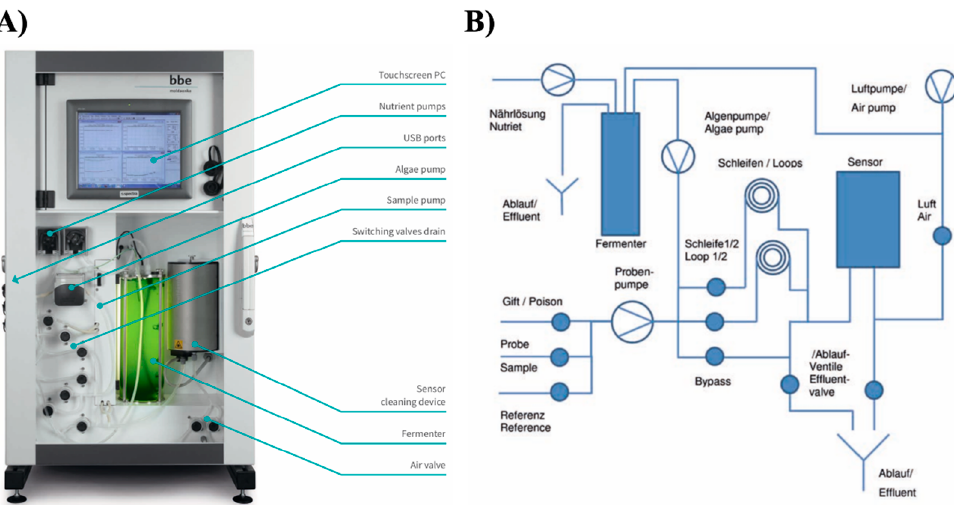
Figure 3. The Algae Toximeter II (bbe Moldaenke GmbH, Germany) is a commercial water biomon- itoring system utilising Chlorella vulgaris microalgae as a bioindicator organism. ( A ) Overview of the device, depicting major functional components. Note an automated on-board photobioreac- tor/fermenter that provides continuous culture of microalgae. Analysis of each water sample takes approximately 45 min and, thus, the Algae Toximeter II is an example of time-resolved but not real- time water sensing technology; ( B ) Technical diagram of the system with its main functional com- ponents. Source data provided by and used with permission from bbe Moldaenke GmbH (http://www.bbe-moldaenke.de (accessed on 1 October 2021)).